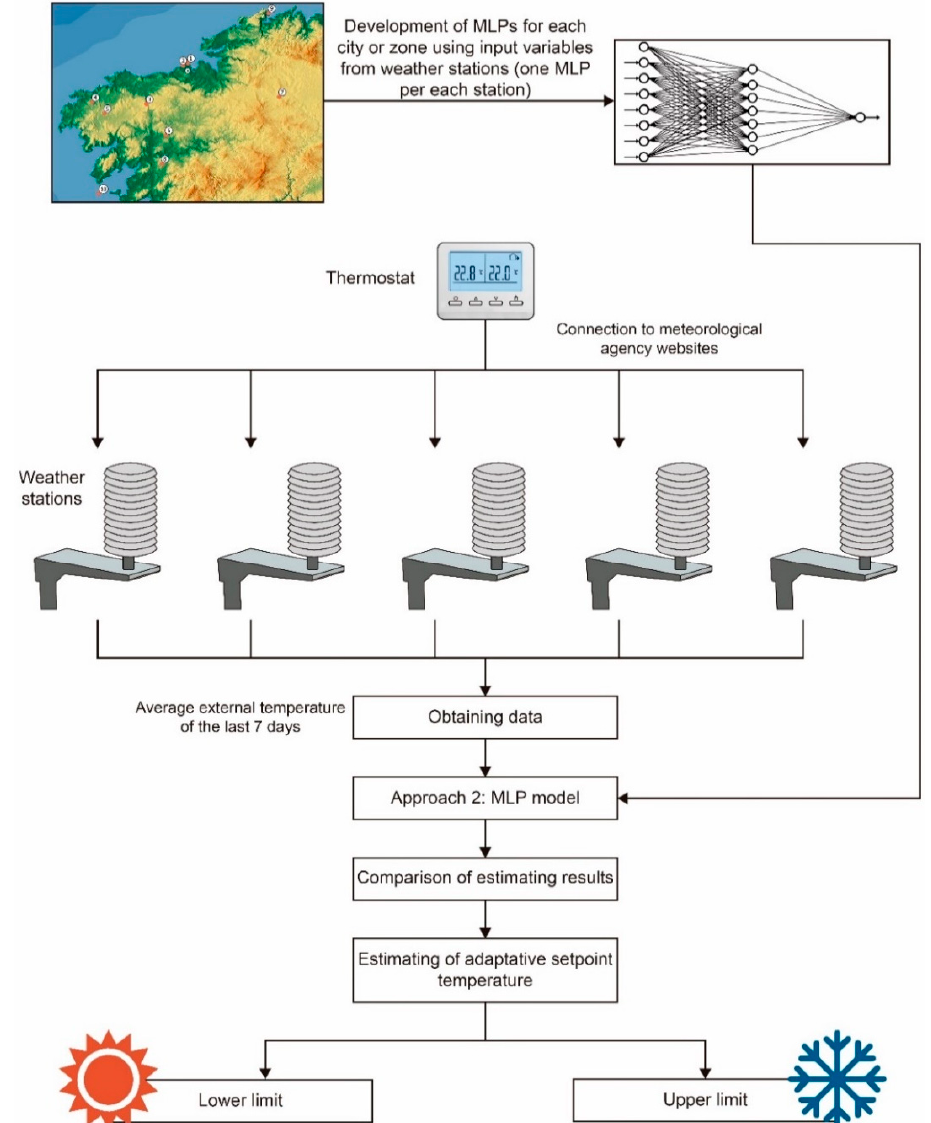
Figure 14. Estimation methodology of adaptive setpoint temperatures. Not using external temperature probes is considered.